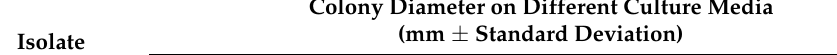
Table 3. Colony diameter of Penicillium, expansum , P. crustosum and P. solitum isolates on different media 7 dpi, in the dark at 24 ± 2 ◦